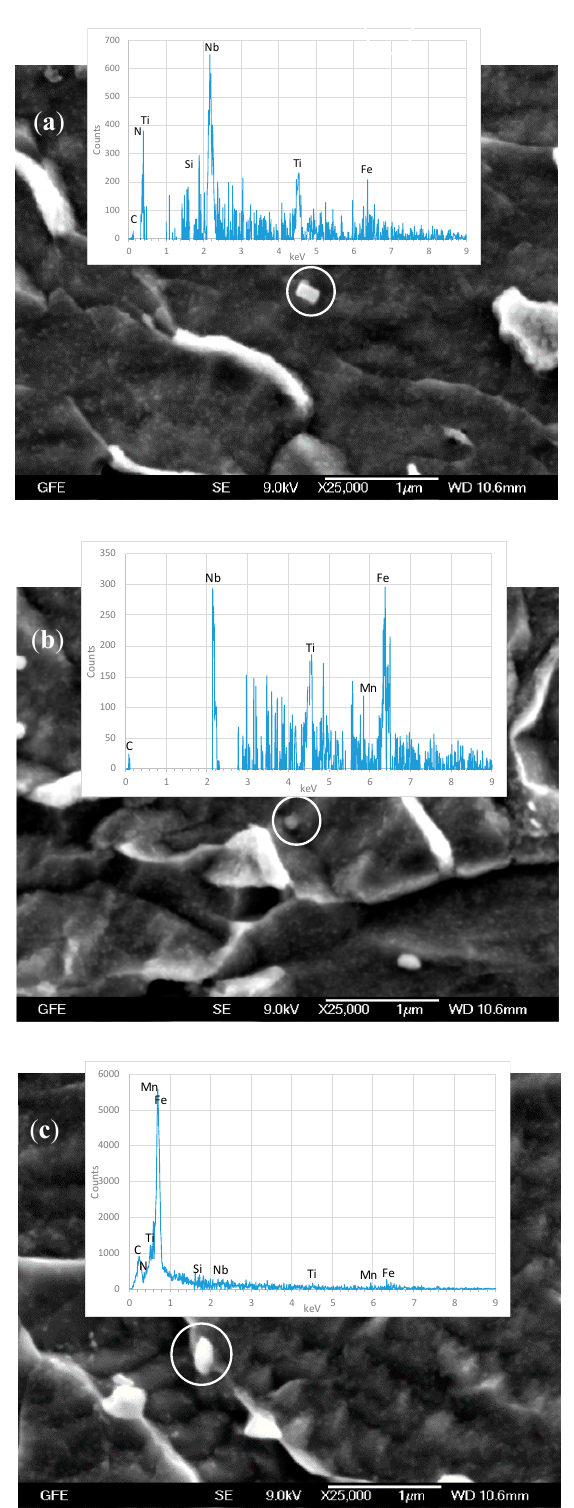
Figure 6. Scanning electron micrographs showing the observed types of precipitates together with the EDX-spectrum of the circled precipitates; ( a ) is (Ti, Nb)(C, N), ( b ) is NbC and ( c ) is cementite.